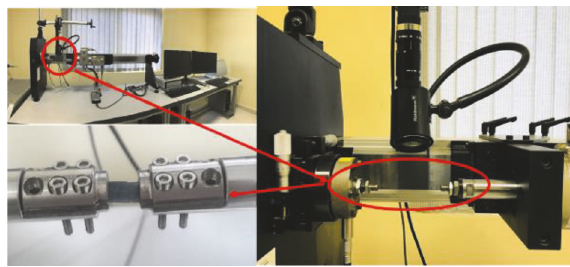
Figure 8: Microtensile test